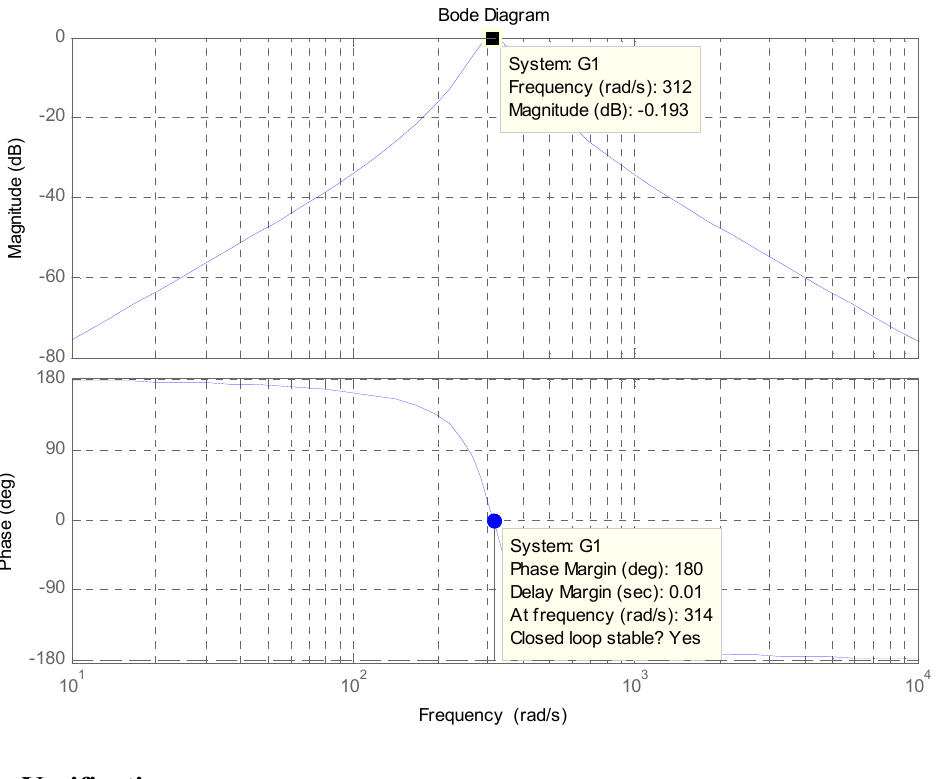
Figure 4. Bode diagram of the proposed band-pass